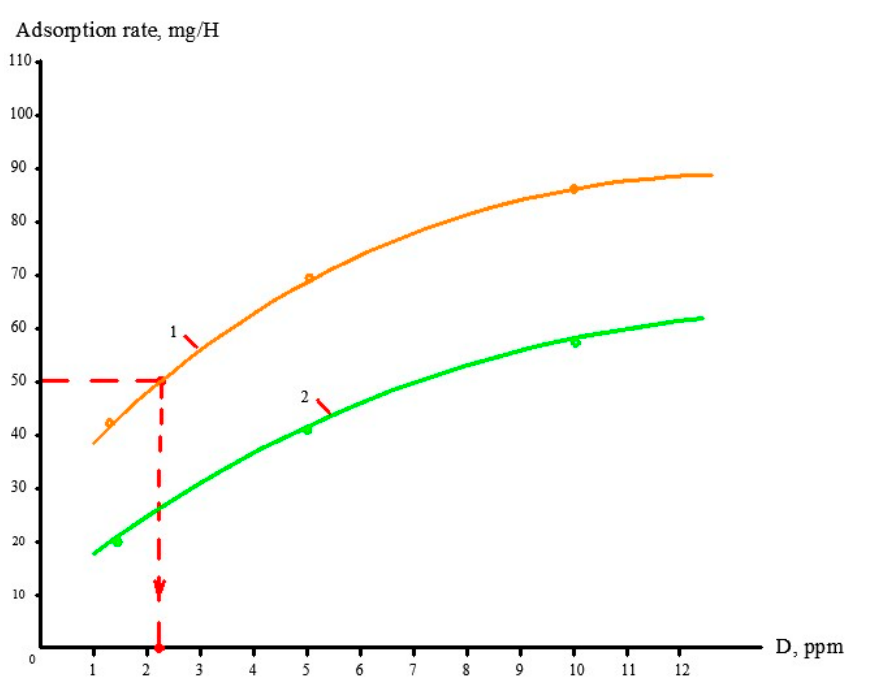
Figure 5. Dependencies of antiscalant adsorption rates on the antiscalant dose values: (1)—Aminat-K; (2)—Jurby-Soft.